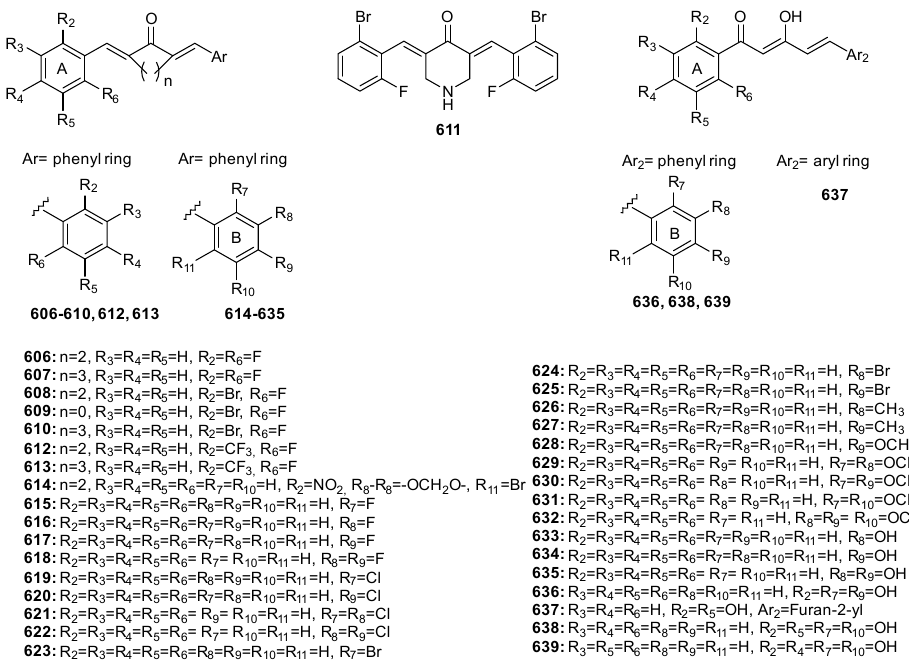
Figure 14. Diarylpentanoids with promising antidiabetic properties.